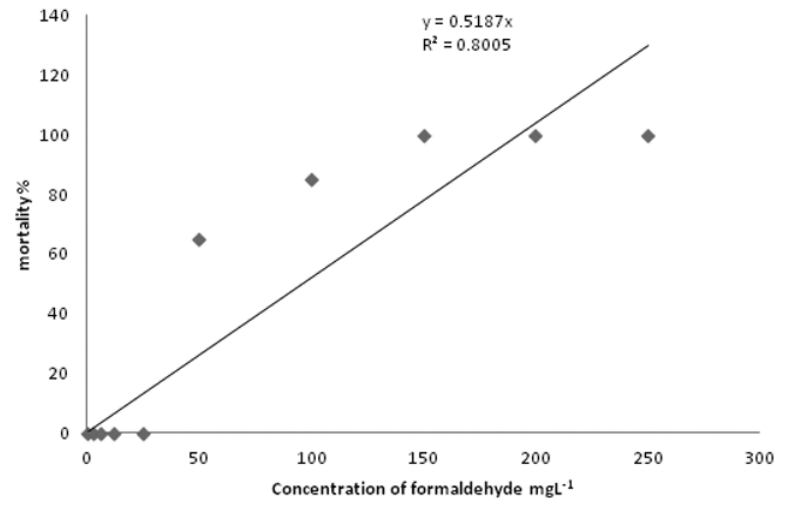
Figure 1 - Relação concentração-mortalidade da corredora bicuda ( Coridora melanistius cf. )